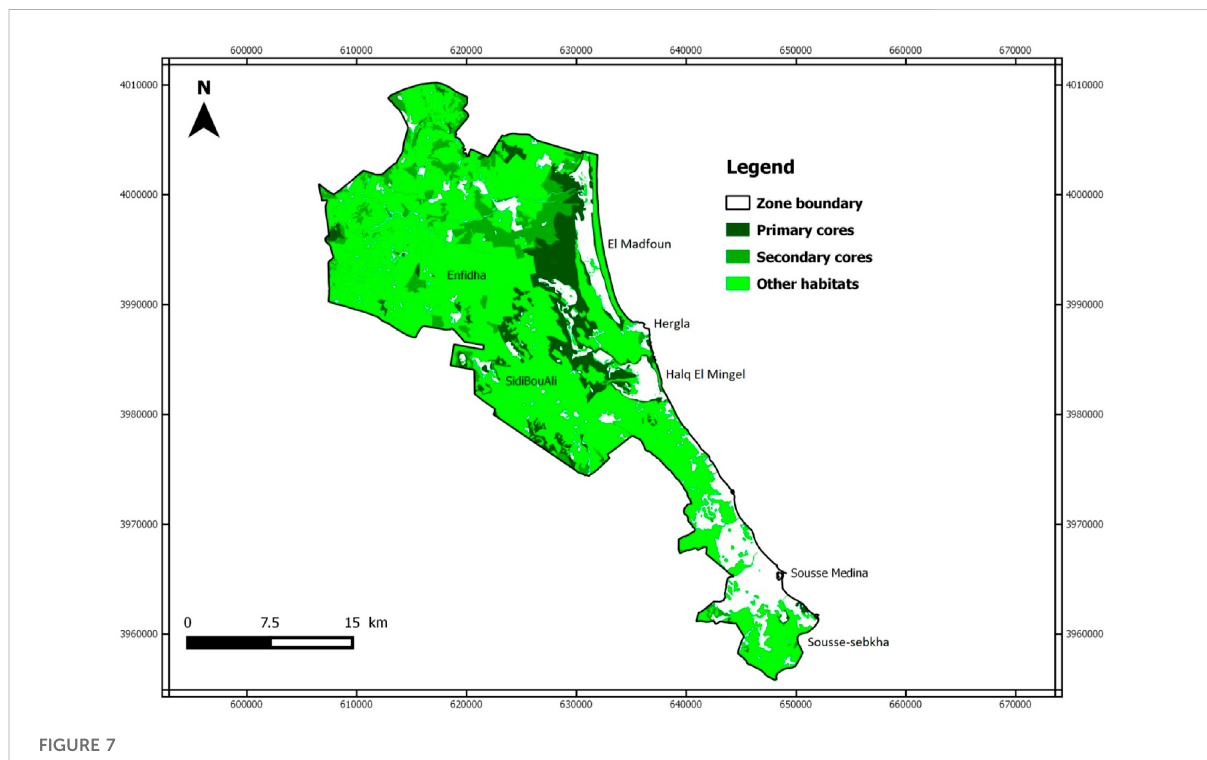
FIGURE 7 Reservoirs of the semi-open habitat